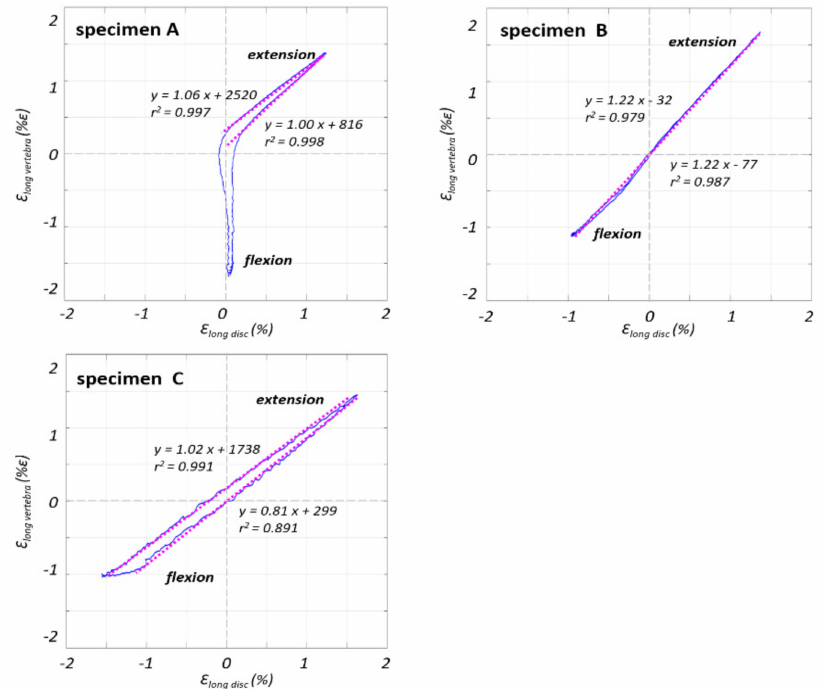
Figure 6. The strain in the ALL in front of the vertebra is plotted against the strain in front of the disc for the third loading cycle, showing a highly linear trend. The regression line is reported with its equation and the r square, separately, for the flexion-to-extension and extension-to-flexion curves. All specimens had the same behavior, again with the exception of specimen A during flexion, which showed no change in the strain values on the IVD when the strain on the VB reached − 2%. Conversely during extension, specimen A showed the same behavior as the other